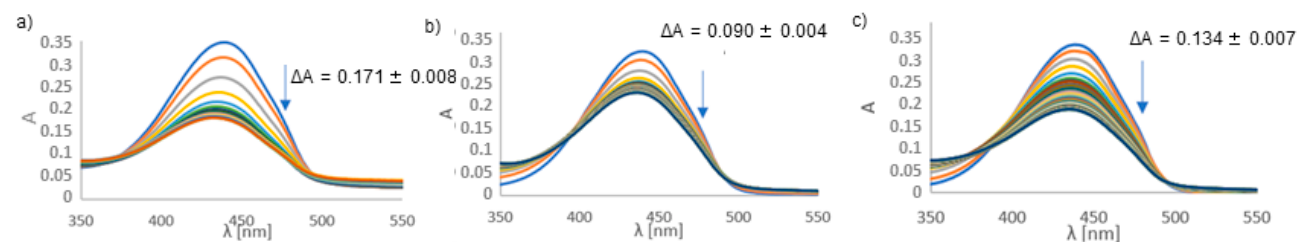
Figure 6. UV-Vis spectra of NDMA in the presence of ascorbic acid measured for one hour every 1 min with ( a ) copper (II) ions (control), ( b ) Cu(II)-L 1 complex and ( c ) Cu(II)-L 2 complex.